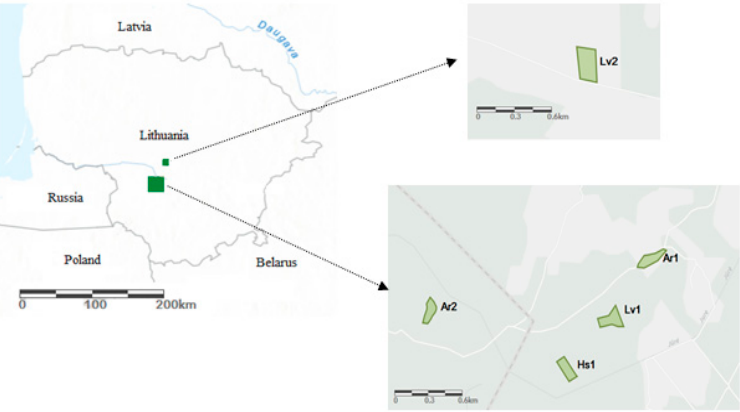
Figure 1. The studied silver birch ( Betula pendula Roth) forest stands in the Kaunas region of the Lithuanian state forest enterprise. Coordinates: Ar1 (54 ◦ 50’ N, 23 ◦ 36’ E); Ar2 (54 ◦ 50’ N, 23 ◦ 38’ E); Lv1 (54 ◦ 50’ N, 23 ◦ 38’ E); Lv2 (55 ◦ 2’ N, 23 ◦ 50’ E); Hs1 (54 ◦ 50’ N, 23 ◦ 37’